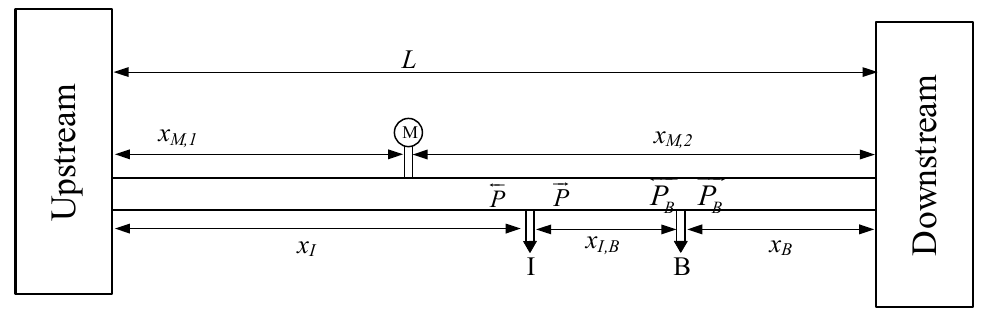
Figure 9. Schematic diagram of the disturbance signal introduced into the pipeline.